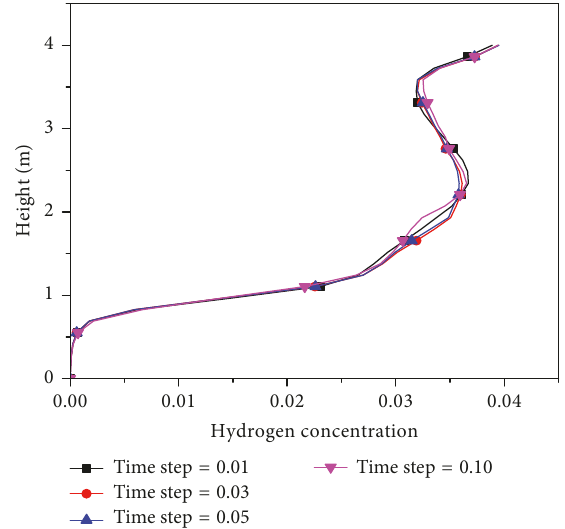
Figure 6: Hydrogen concentration for different time steps on line 1 in source term compartment of case 1